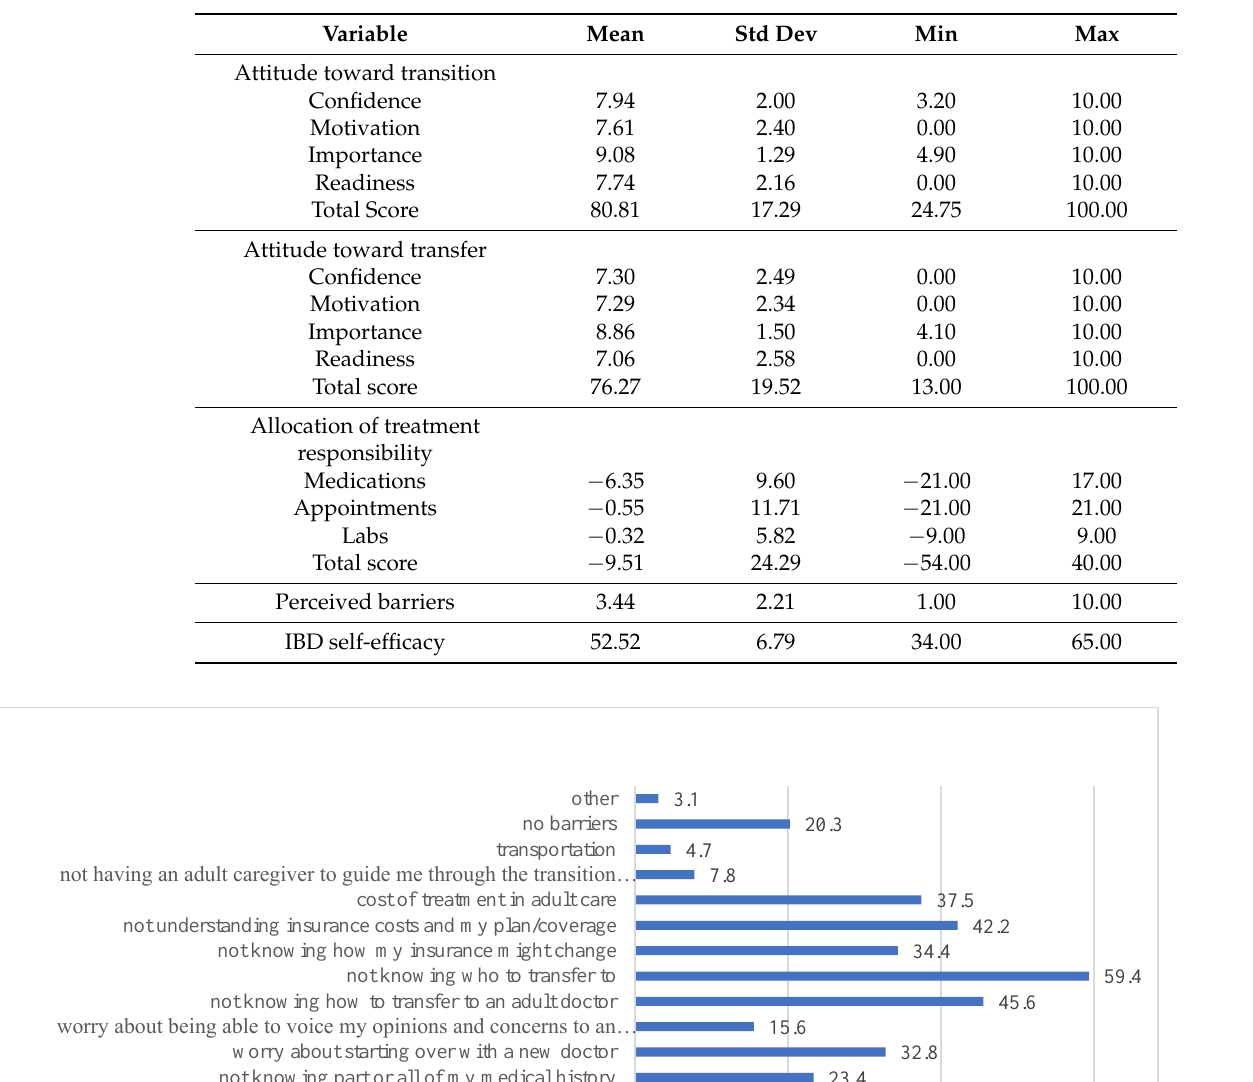
Table 2. Descriptive data for the study measures.